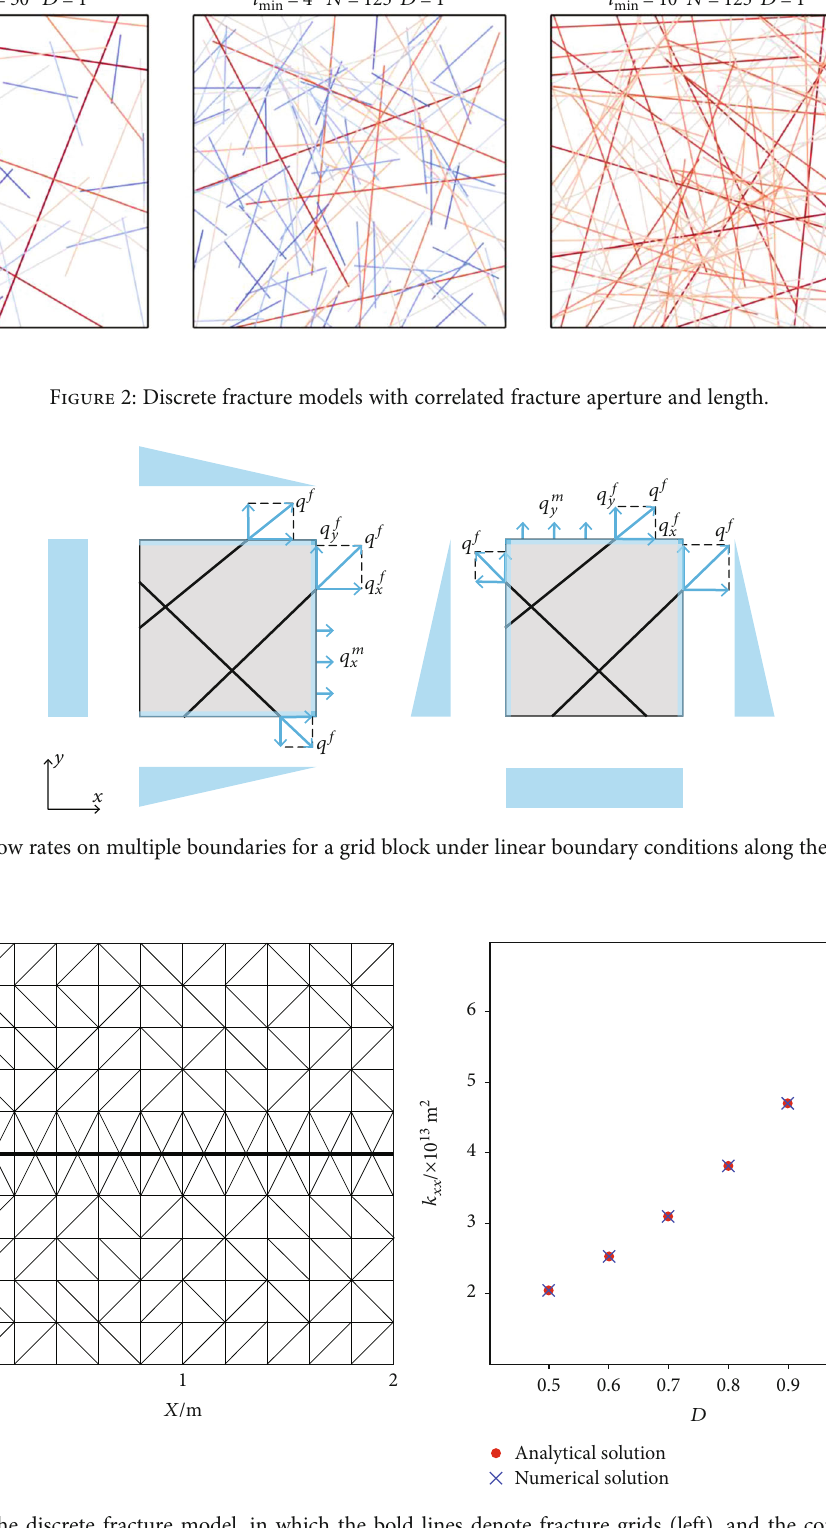
Figure 4: Meshes for the discrete fracture model, in which the bold lines denote fracture grids (left), and the corresponding equivalent permeability component k xx for di ff erent correlation exponents D